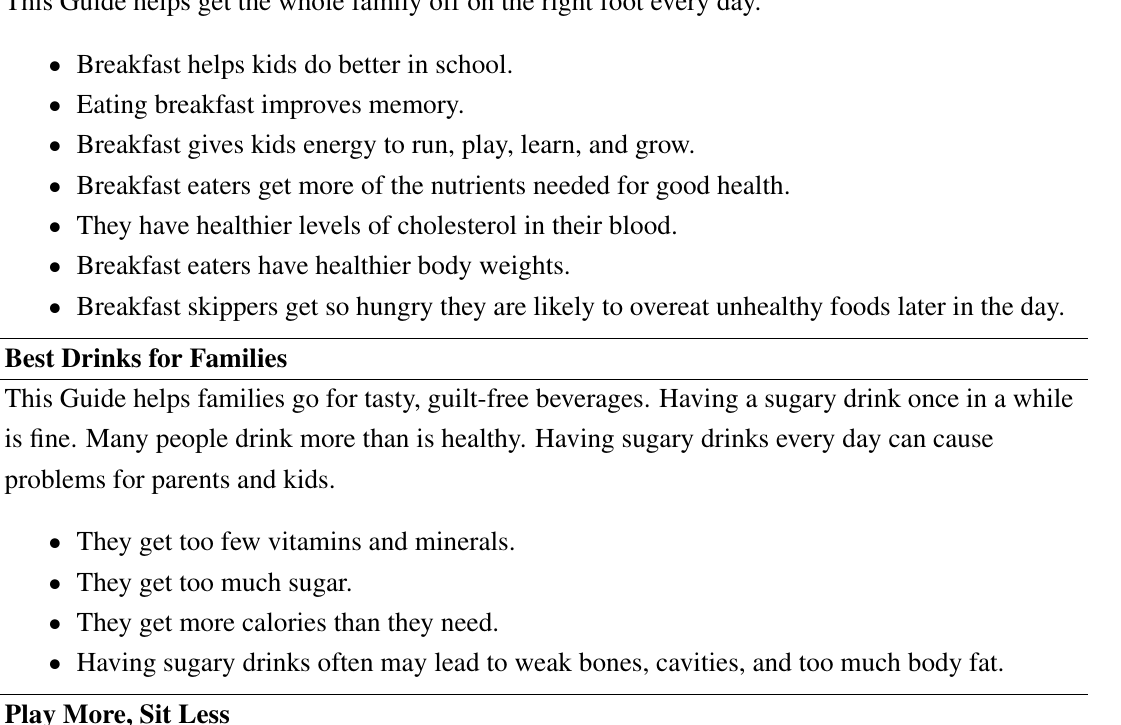
Description and Main